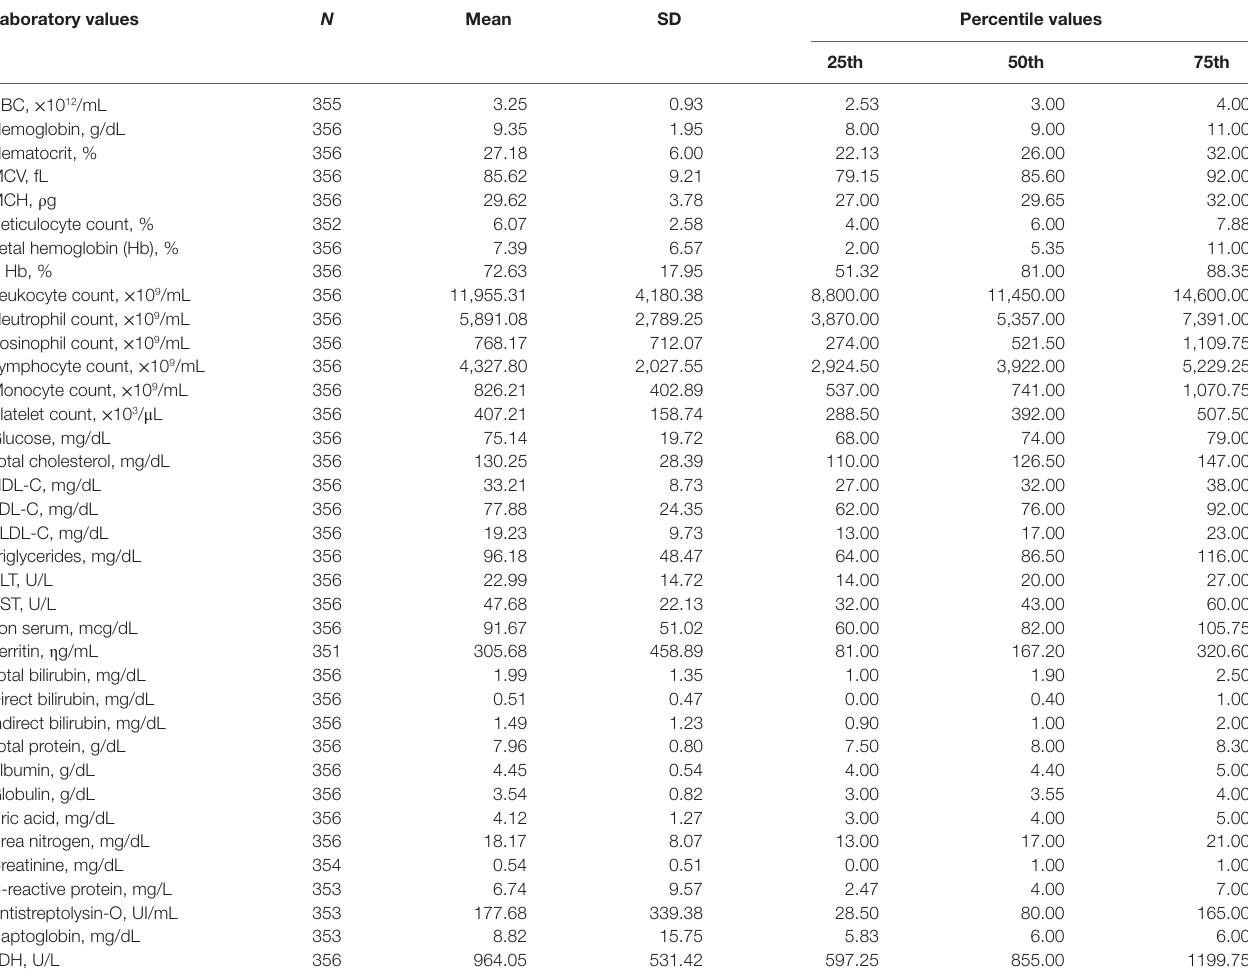
Table 1 | Hematological and biochemical laboratory parameters of patients with sickle cell disease. laboratory